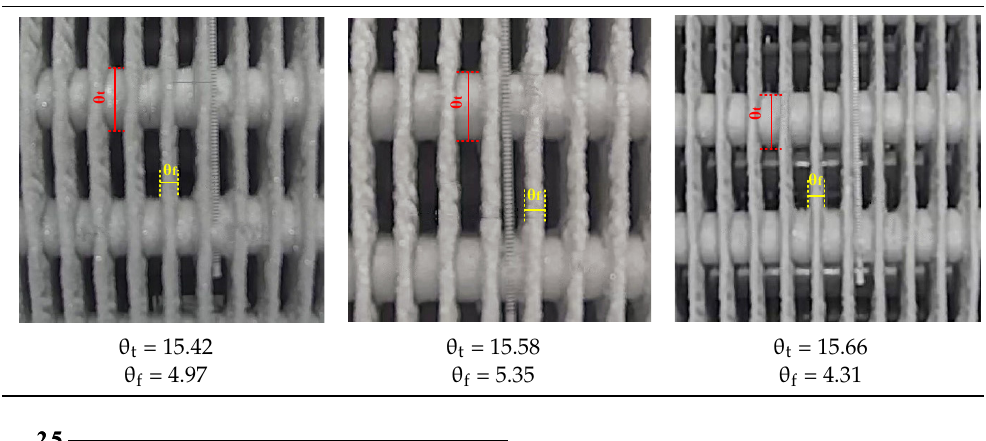
Table 5. Pictures of frosting conditions at measuring point 5 after 18 h of system operation, where θ t is the frosting thickness of the evaporator tubes (mm) and θ f is the frosting thickness of the fins (mm). Φ = 0.74 Φ = 1.2